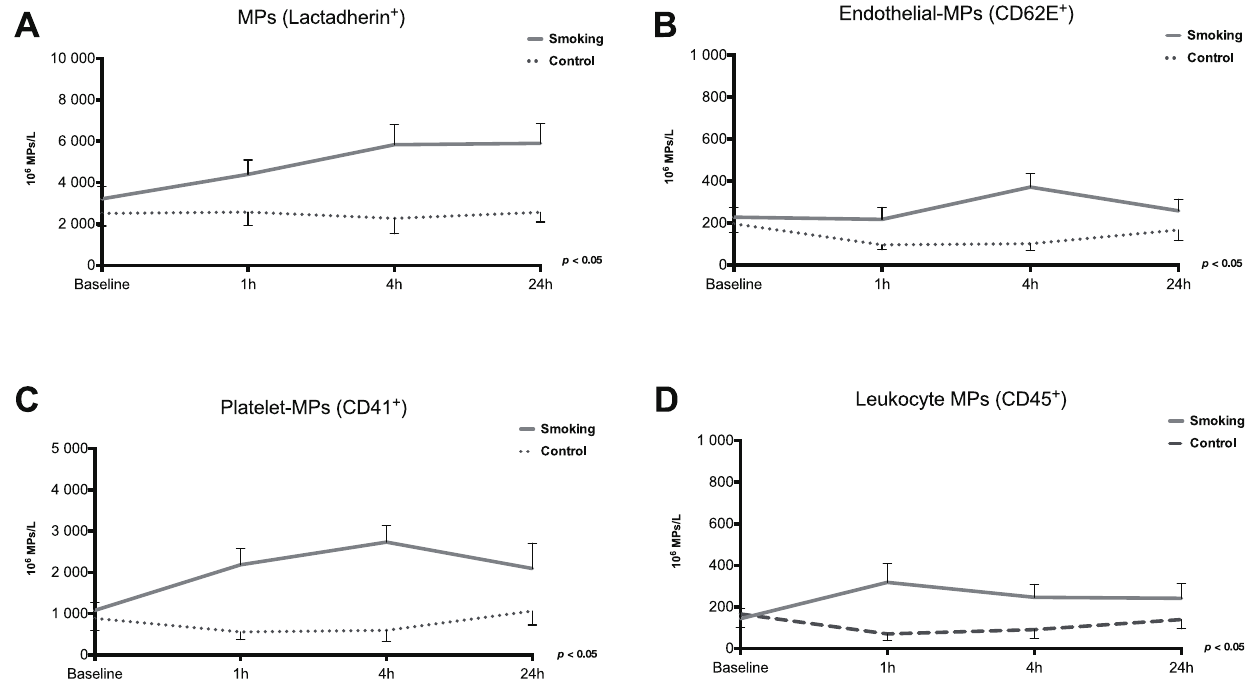
Figure 3. Microparticles during smoking and control. Microparticles were measured by flow cytometry and gated according to size and phosphatidylserine exposure (A) together with cell-specific antigens to determine cellular origin; endothelial-MPs (B), platelet-MPs (C) or leukocyte- MPs (D). Data is presented as mean 6 SE. Statistical differences (two-factor ANOVA) are indicated for each panel. doi:10.1371/journal.pone.0090314.g003 Table 1. Microparticles during smoking and